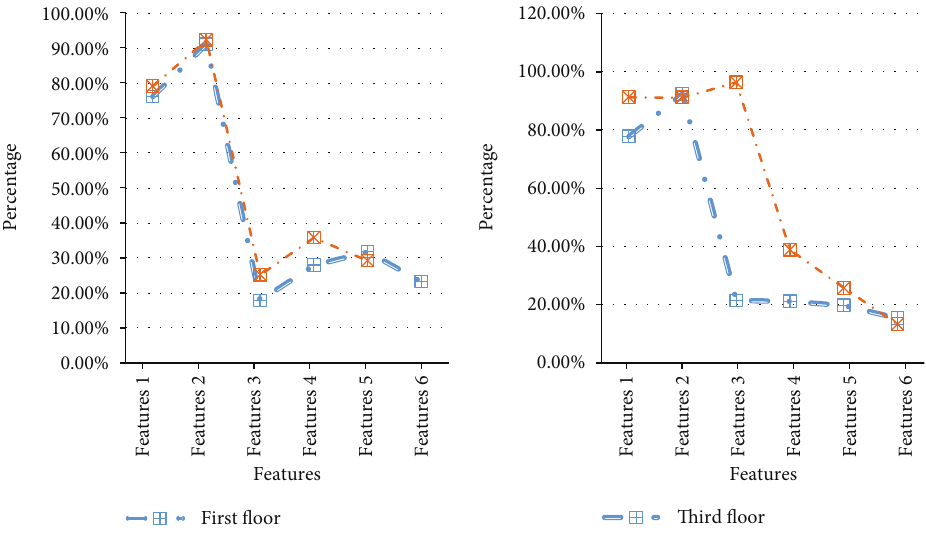
Figure 8: E ffi ciency of feature extraction by di ff erent layers of convolutional neural